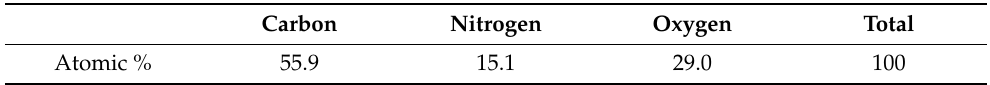
Table 2. EDX analyses of quantum dots. Atomic percentages of C, N and are averaged over three different areas for each of the two sample holders employed.